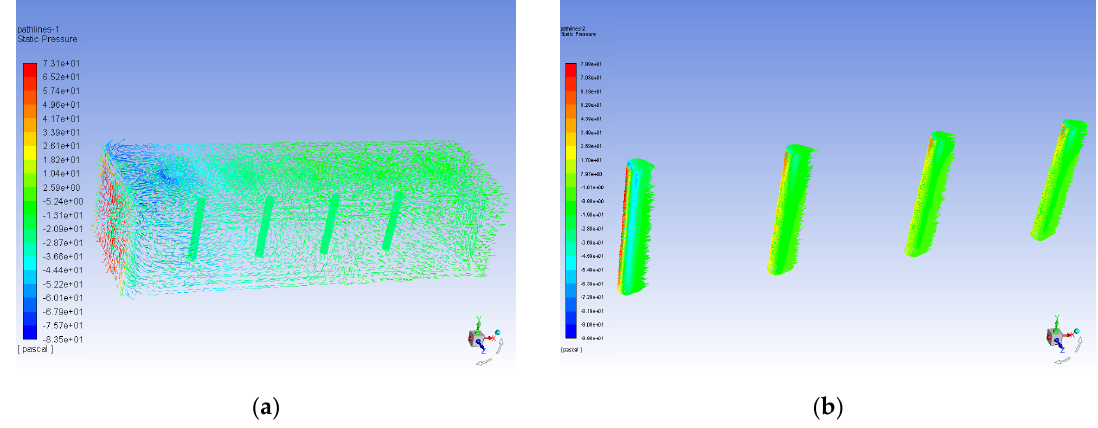
Figure 7. Pressure simulation comparison of hair surface in the artificial lateral line system at flow velocity field of 10 m / s. ( a ) Pressure path-lines diagram of canal neuromast flow velocity sensor; ( b ) Pressure path-lines diagram of superficial neuromast flow velocity sensor.